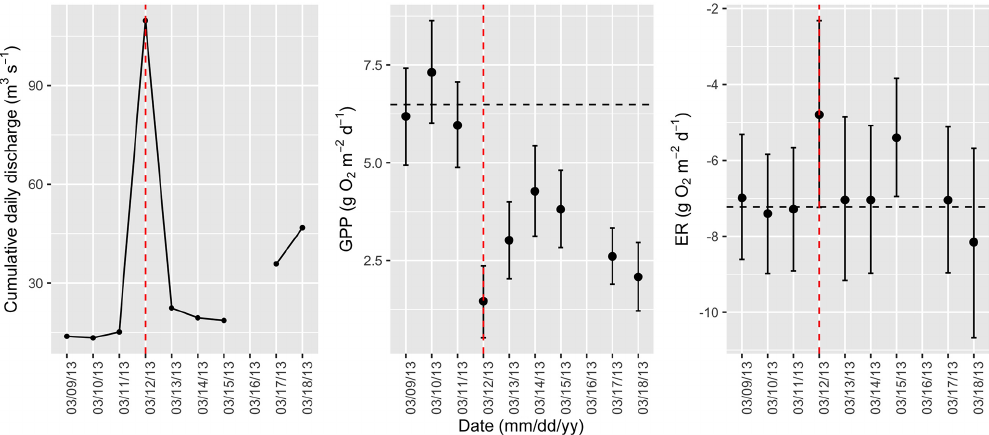
Figure A4. Cumulative daily discharge and metabolism (gross primary production and ecosystem respiration; GPP and ER) time series for the Stroubles Creek flow event on 12 March 2013 (noted with a dashed vertical red line in all three panels). The dashed horizontal black lines are mean values of GPP and ER prior to the high flow event. Error bars for posterior estimates of GPP and ER are 2.5% and 97.5% Bayesian credible intervals.